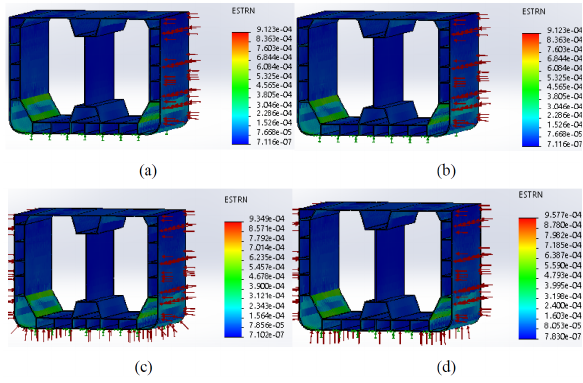
Figure 8: (a) Comparison of a strain contour plot with various ma- terial types: (a) Grade AH36, (b) Grade AH32, (c) AISI 1020, and (d) AISI 1035.